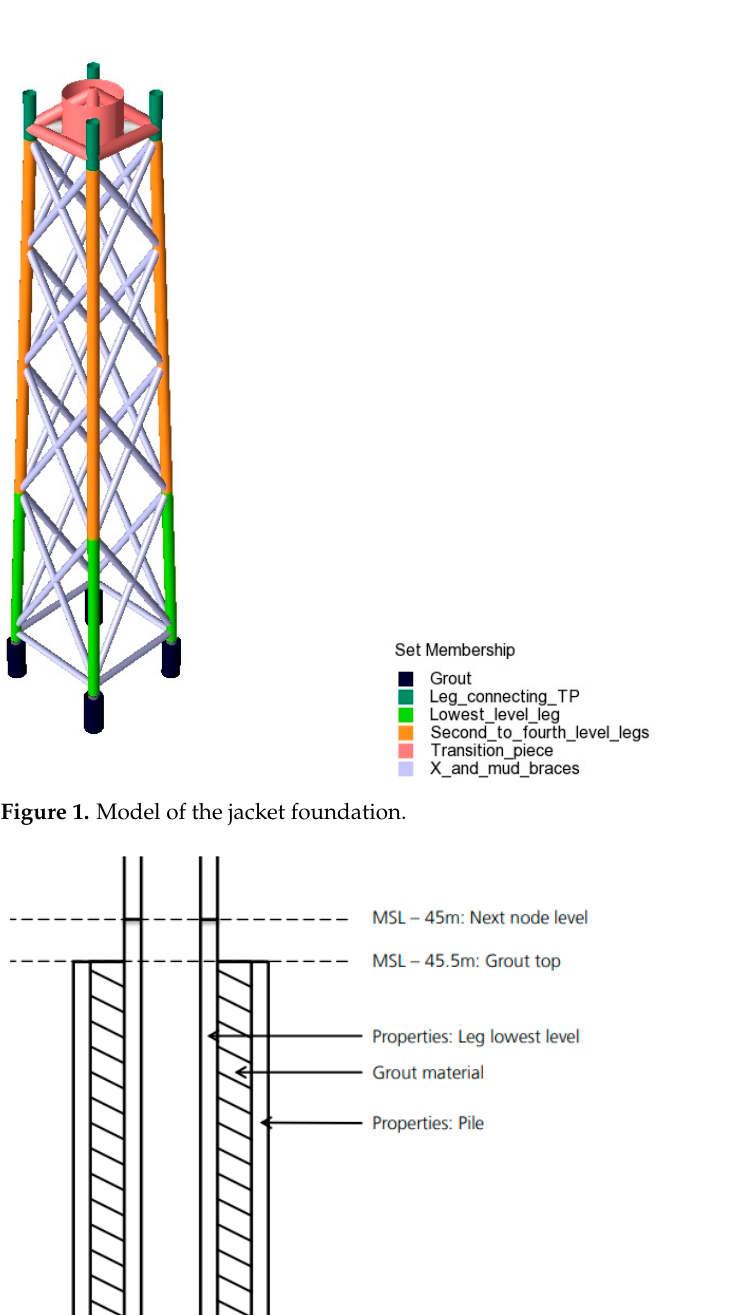
Figure 1. Model of the jacket foundation.